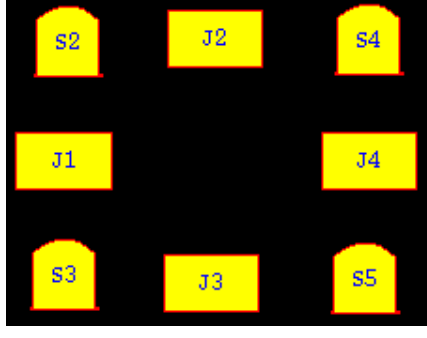
Figure 3. Equipment network for Example 1.